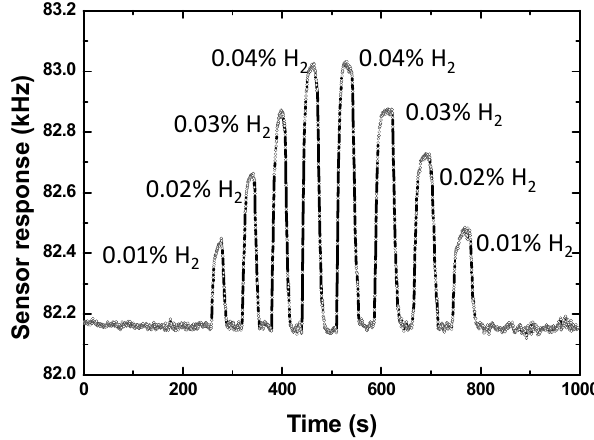
Figure 7. The measured sensor response relating to various hydrogen gas concentrations from the 40 nm Pd-Ni alloy thin-film coated sensing device.